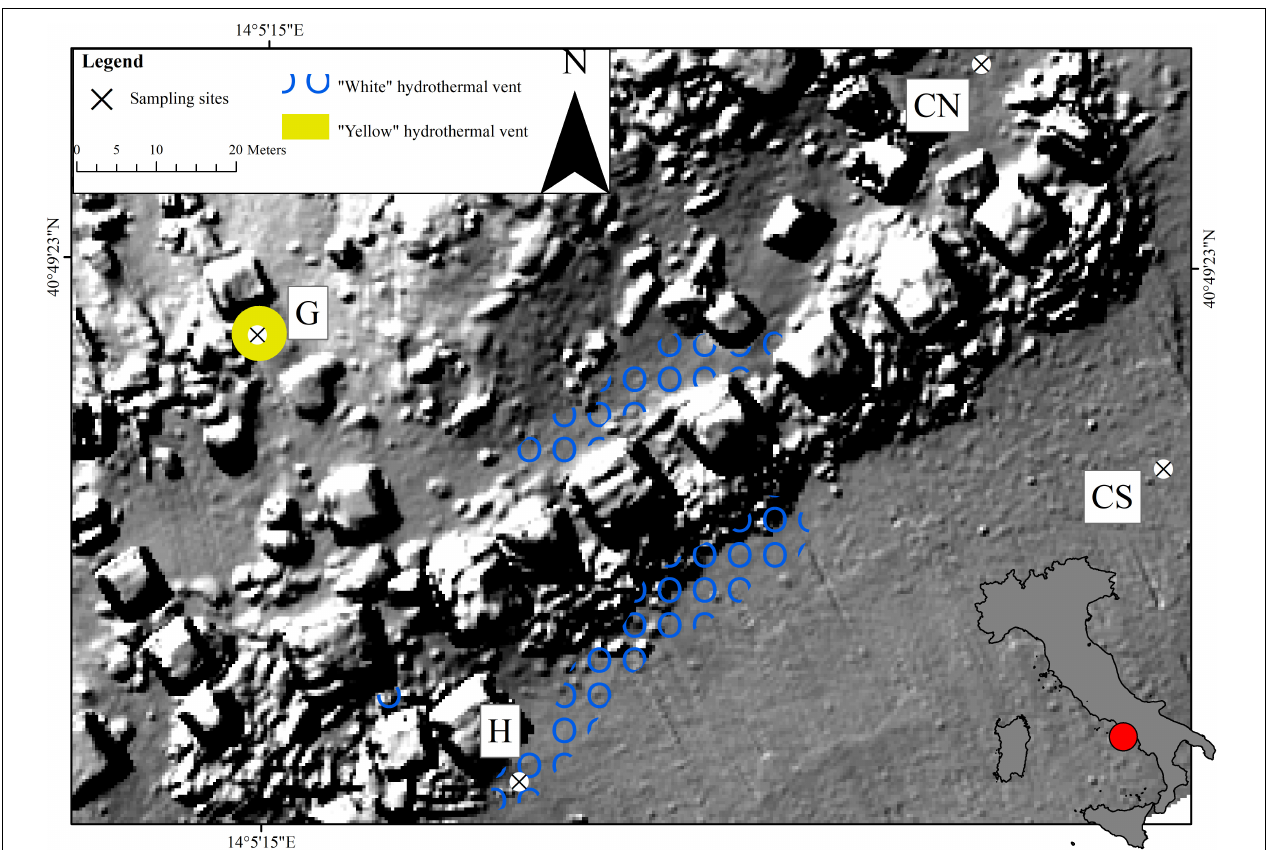
FIGURE 1 | Study area showing the sampling sites (H – White hydrothermal vent; G – Geyser; CN – Control North; CS – Control South) around pillars of the Roman age at Secca delle Fumose (Gulf of Naples,